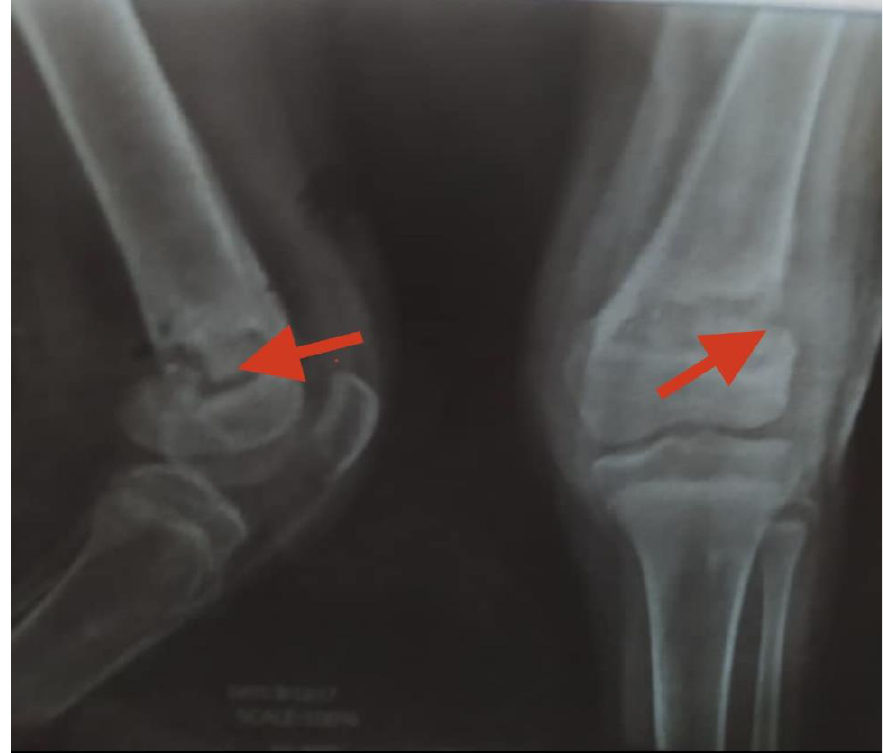
Figure 3. Plain radiograph of the right and left knee with osteomyelitis (red arrows) following the insertion of percutaneous cross-pins.